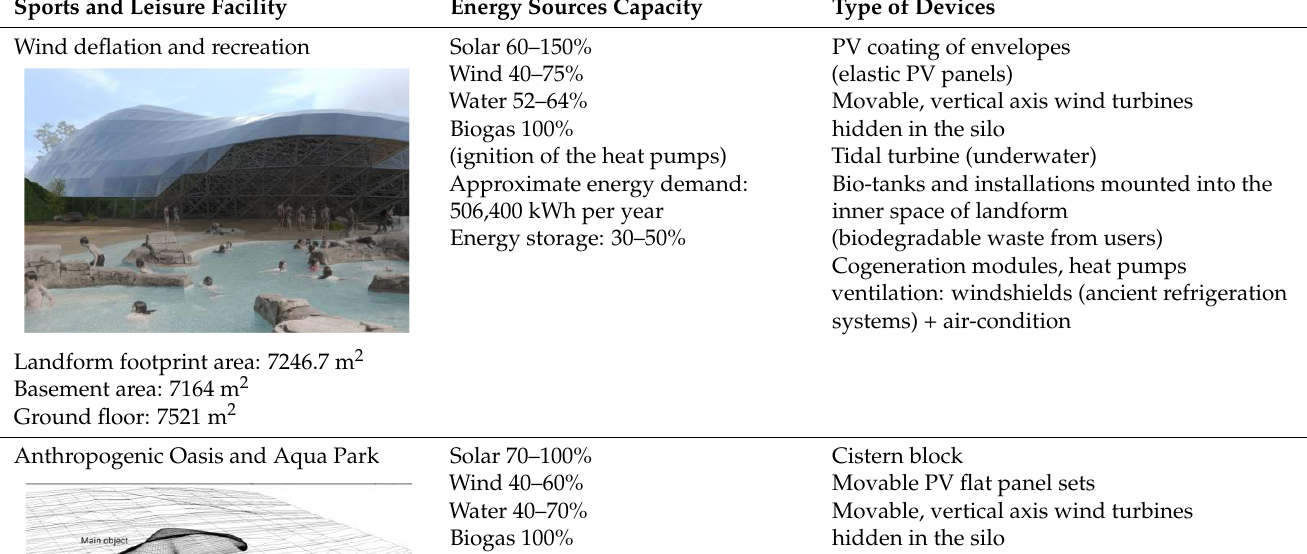
Table 2. Integration of various renewable energy sources into envisioned facilities and approximate energy demands. Sports and Leisure Facility